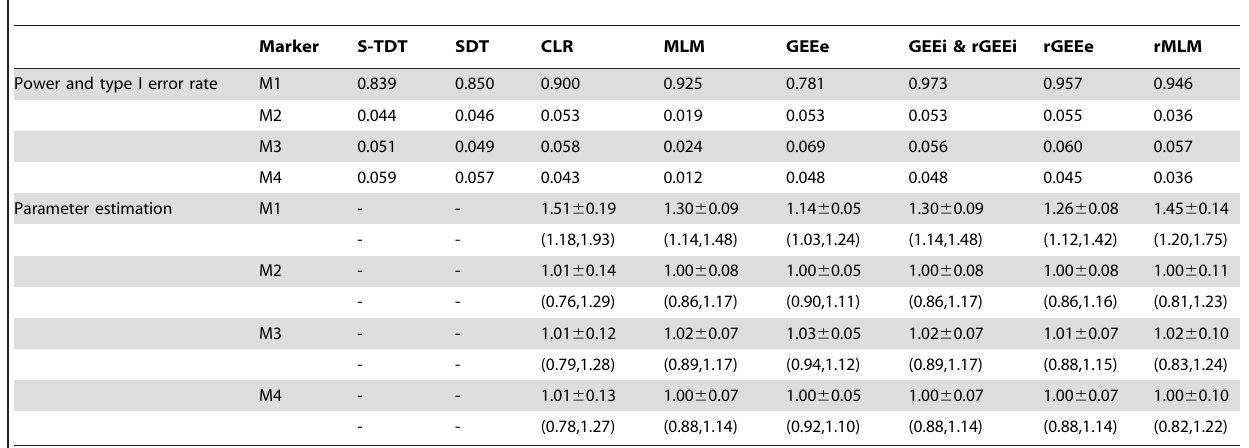
Table 2. Measures of power (M1), type I error (M2–M4) and parameter estimate (average OR, empirical standard error and 95%CI) of scenario 9 in which the simulated datasets contain affected cousin